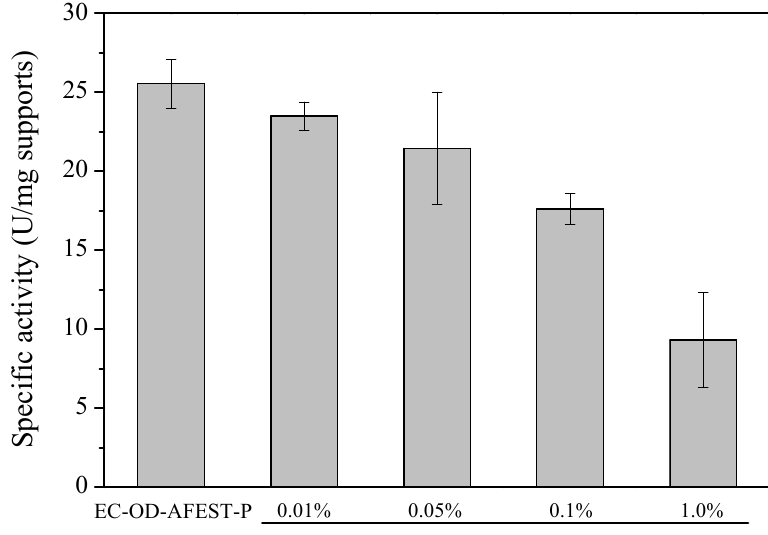
Figure 1. Effect of glutaraldehyde concentration on the specific activity of immobilized